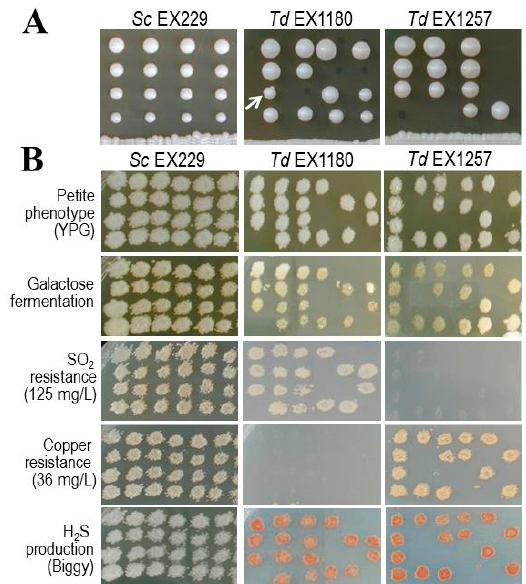
Figure 1. Genetic characterization of T. delbrueckii . ( A ) Spore colony size after tetrad dissection of Sc EX229, and Td EX1180 and Td EX1257 strains. Spore tetrads from separate asci are arranged along vertical lines. Sectored colony is indicated with an arrow. ( B ) Examples of some phenotype tests after replica plating of some spore clones on the media indicated (on the left). YPG, Yeast extract–Peptone– Glycerol medium.